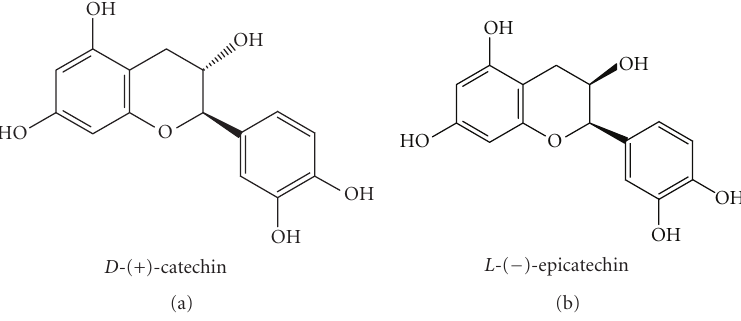
Figure 2: Absolute stereochemistry configuration of the catechols.